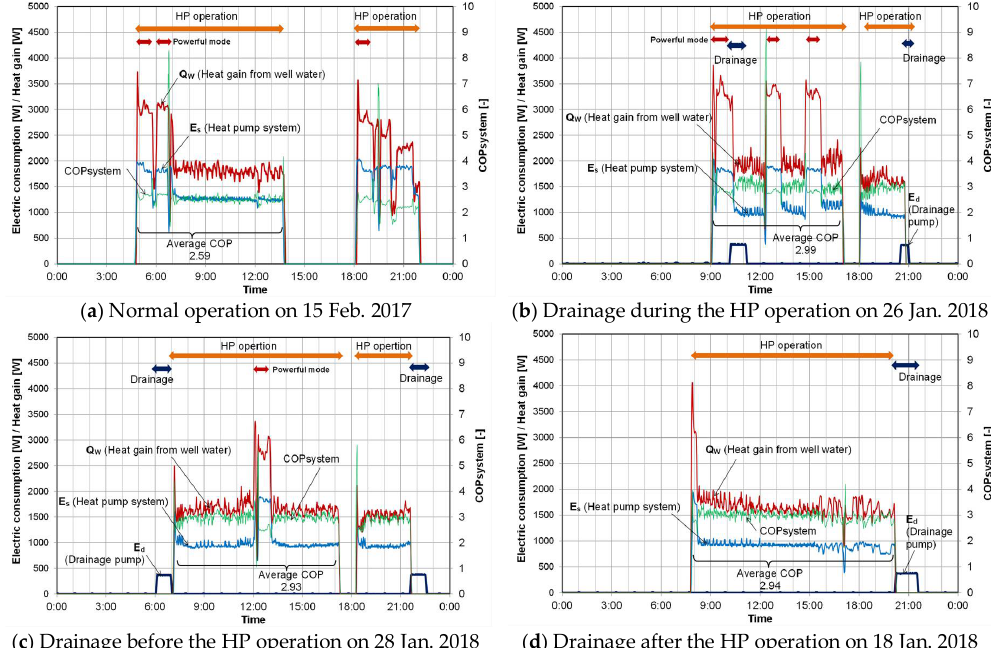
Figure 8. Electric power consumption and efficiency change in each operation pattern.